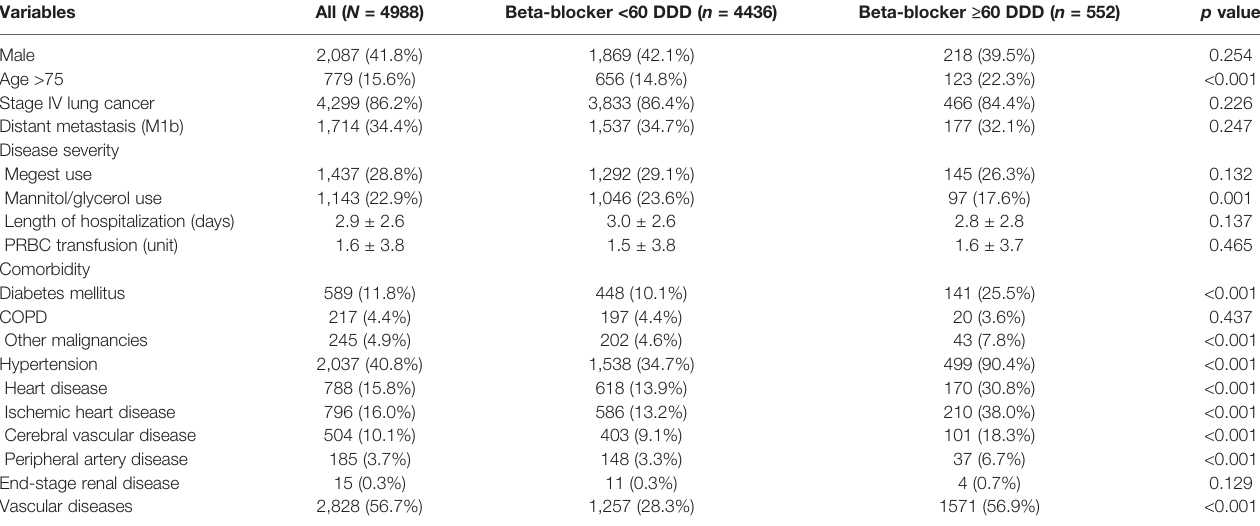
TABLE 1 | Patient characteristics, strati fi ed by beta-blocker